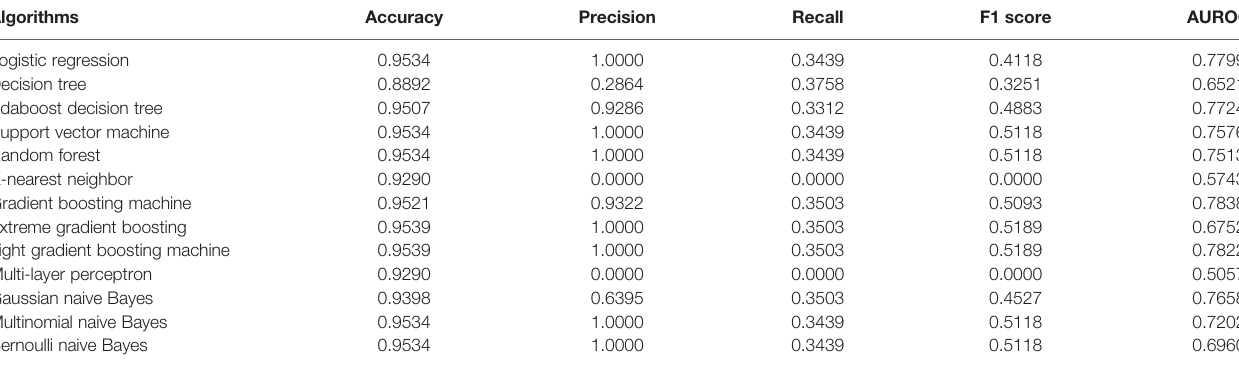
AUROC, area under the receiver operating characteristic curve.